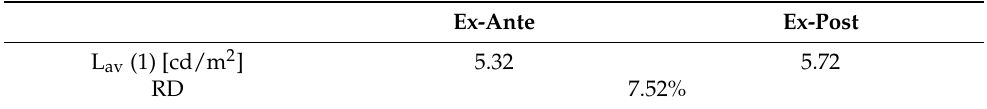
Figure 8. Comparison of the measured and simulated average luminance values from the internal viewpoint I1 . ( a ) Measured luminance distribution; ( b ) simulation output. Table 4. Comparison of the measured and simulated average luminance values from the internal viewpoint I1 . (1) building façade.